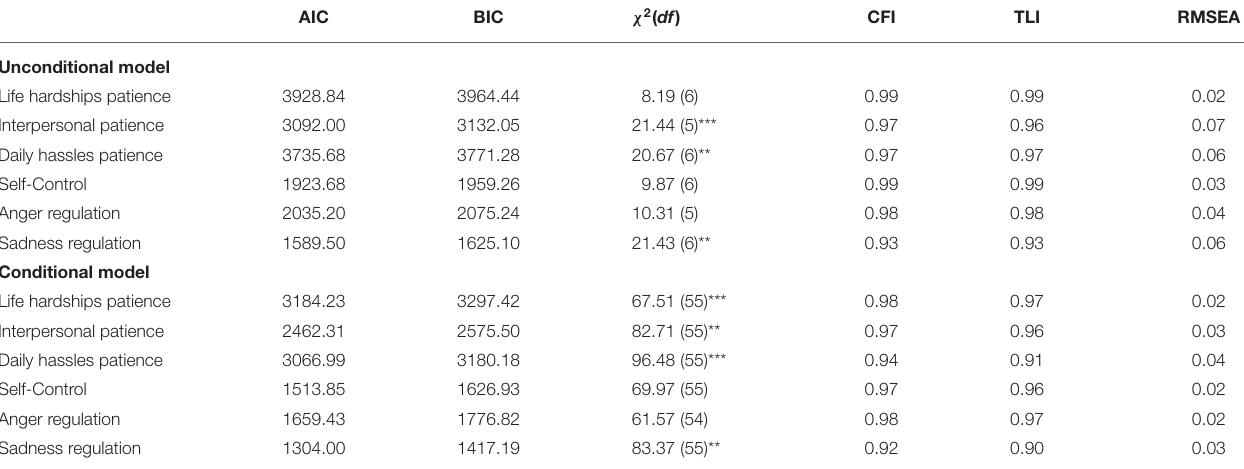
TABLE 2 | Model fit indices for latent growth curve